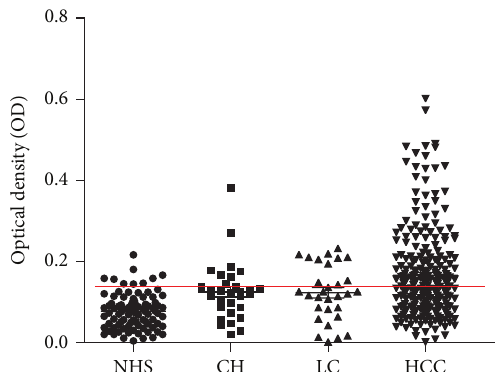
Figure 1: Titer of autoantibody against MDM2 in human sera by ELISA. The range of antibody titers to MDM2 was expressed as optical density (OD) obtained from ELISA. The mean + 3SD of NHS wasshowninrelationshiptoallserumsamples.Titerofanti-MDM2 in HCC was much higher than that in other types of sera ( 𝑃 < 0.01 ). The cutoff value line for positive samples is indicated with red color.